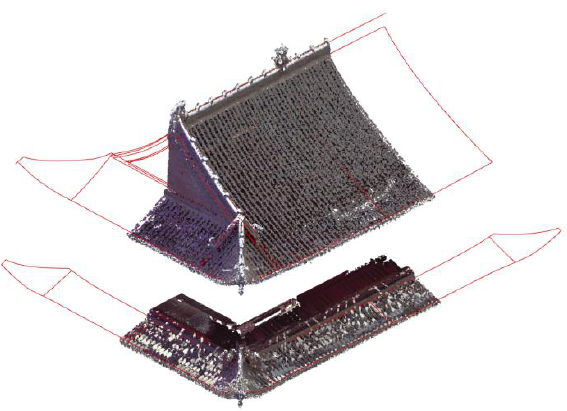
Figure 13. Extracting skeleton curves with referenced point cloud Pick the profile curves to Grasshopper, connect to the input of algorithm generator, and adjust other inputting parameters, e.g. Figure 14.